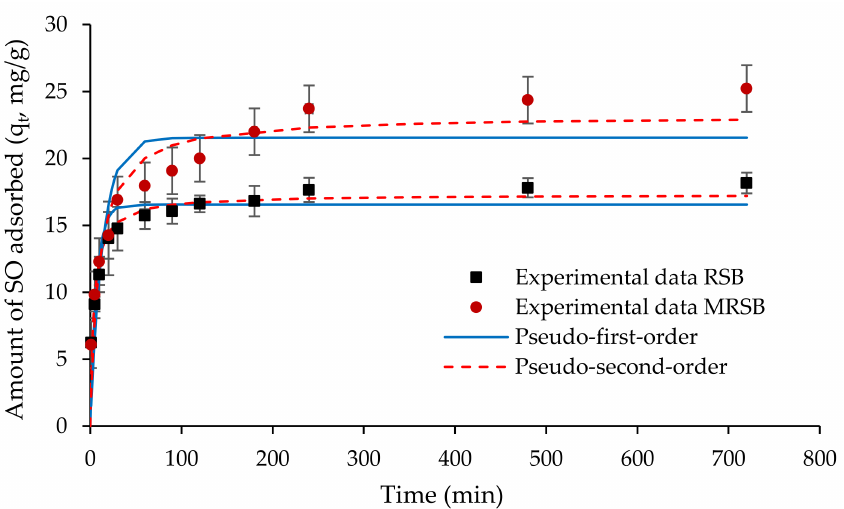
Figure 6. Fitting of pseudo-first-order and pseudo-second-order models for SO adsorption onto RSB and MRSB (Experimental conditions: C 0 = 50 mg/L, m adsorbent = 2g/L, t = 1–720 min, pH ~7).